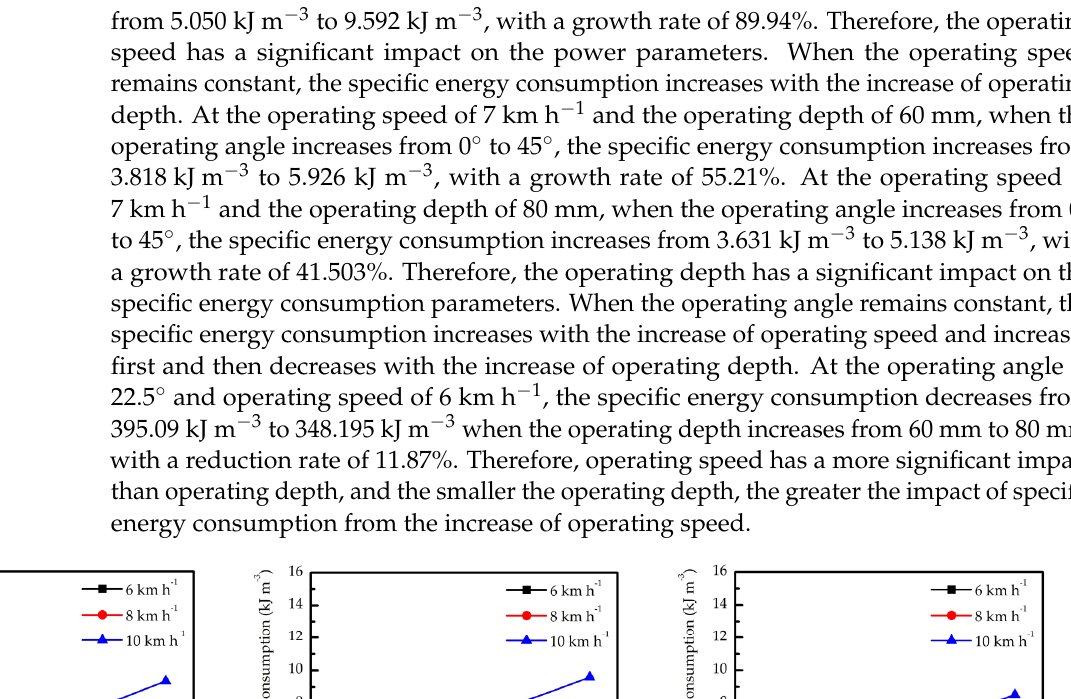
Table 2. Optimization model of test data.